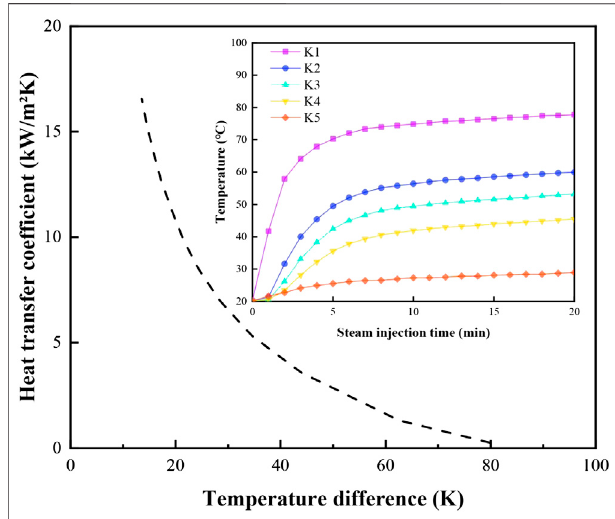
FIGURE 5 | Variation in the heat transfer coef fi cient of steam on the condensation surface with temperature difference (the attached fi gure shows the change of temperature at thermocouple position with steam injection